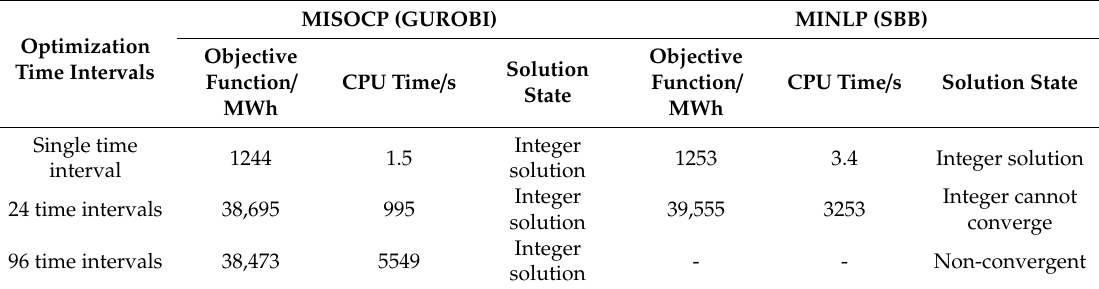
Table 3. Comparison of the results of di ff erent optimization models with di ff erent solvers.